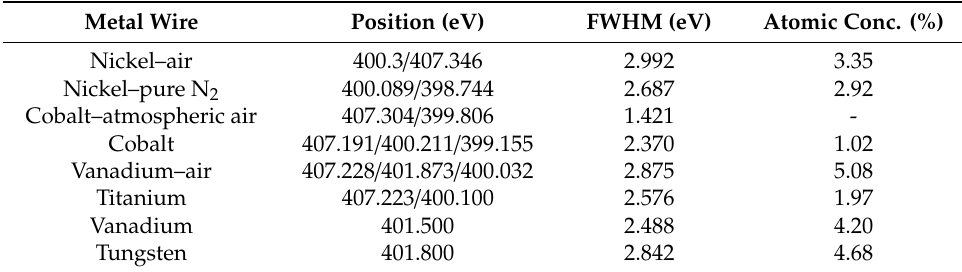
Table 1. Comparative representation of N 1s peaks of di ff erent metal wires used in the sparking discharge process with no magnetic field under di ff erent